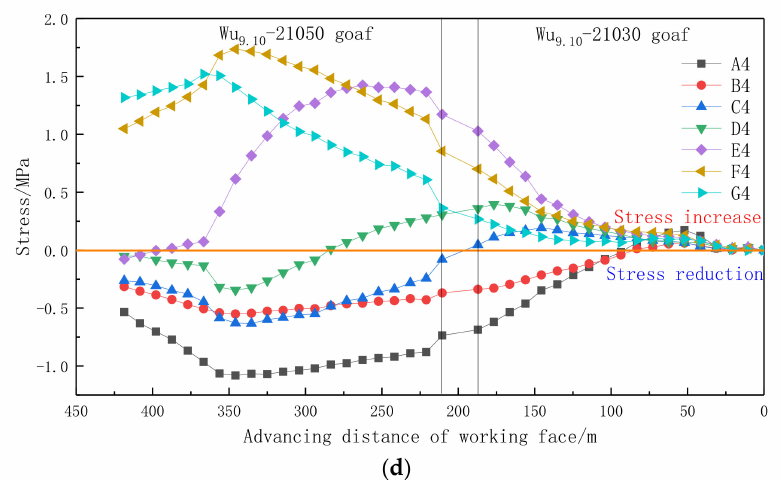
Figure 10. Stress evolution law of different layers of floor during mining of Group E coal seam: ( a ) Evolution law of floor 6 m stress in the mining process of Group E coal seam; ( b ) Evolution law of floor 6 m stress in the mining process of Group E coal seam; ( c ) Evolution law of floor 101 m stress in the mining process of Group E coal seam; and ( d ) Evolution law of floor 179 m stress in the mining process of Group E coal